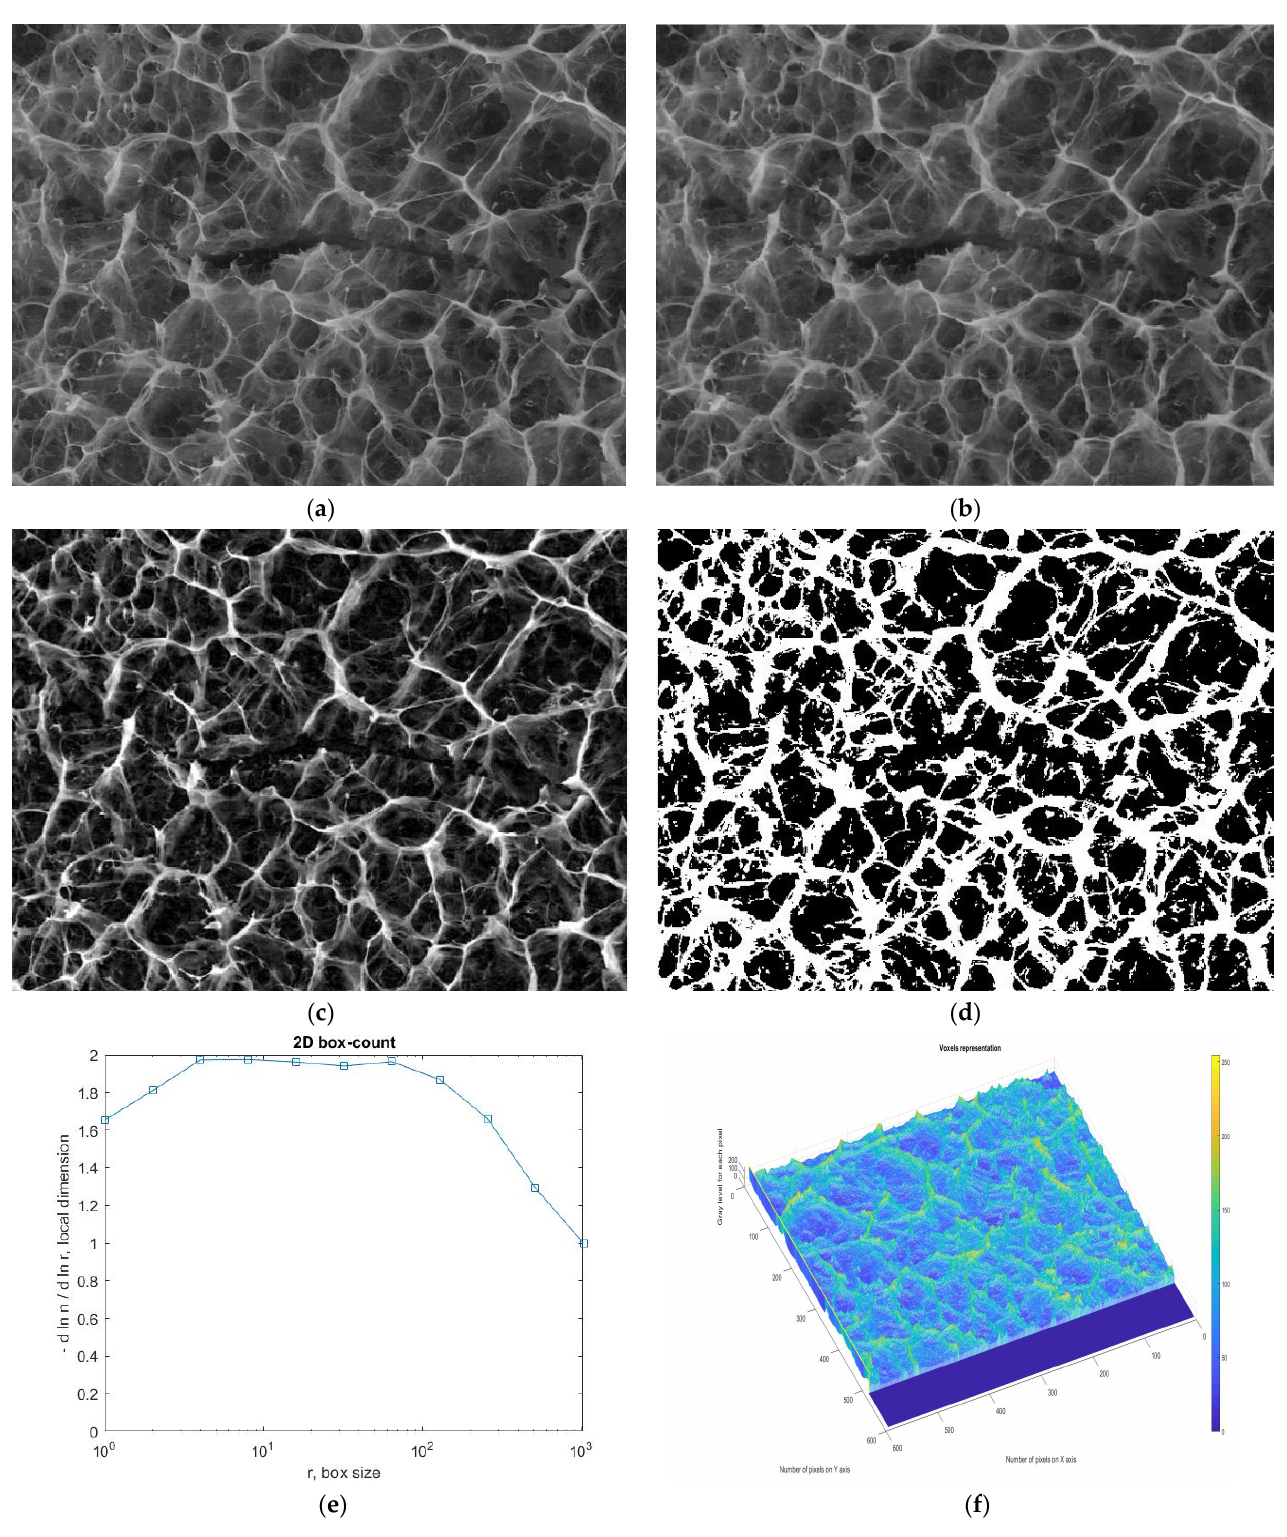
Figure 9. Fractal investigation of image B: ( a ) Black and white version of image B, ( b ) Grayscale version extracted from the background, ( c ) Grayscale version with luminance, ( d ) Binary version, ( e ) Box-count representation, ( f ) Voxel representation For image B, we determined the following values obtained by applying the fractal analysis procedure: the fractal dimension d = 1.9171 with a standard deviation of ± 0.10422 and lacunarity λ = 0.6581.